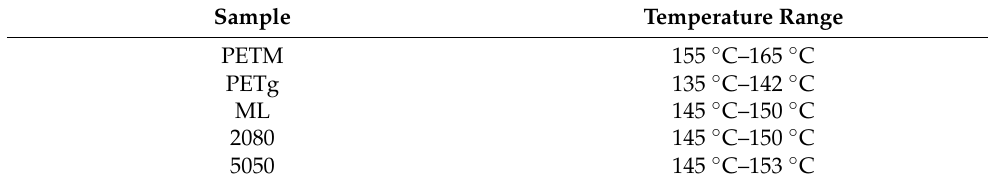
Table 3. Useful temperature range for thermoforming the PETM, PETg and multilayer sheets.